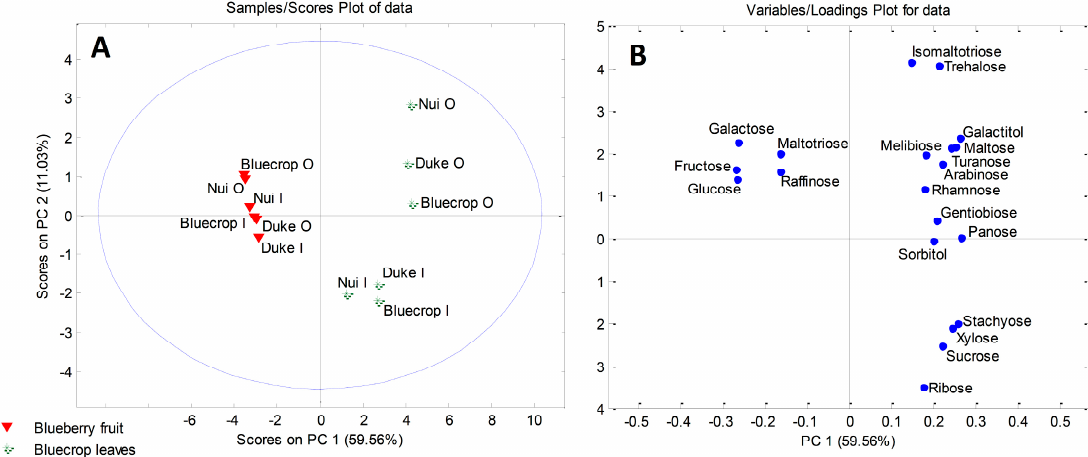
Figure 3. PCA model for sugar-based classification and differentiation of strawberry fruits and leaves: ( A ) score plot; ( B ) loading plot. Organic (O) and integrated (I) production.